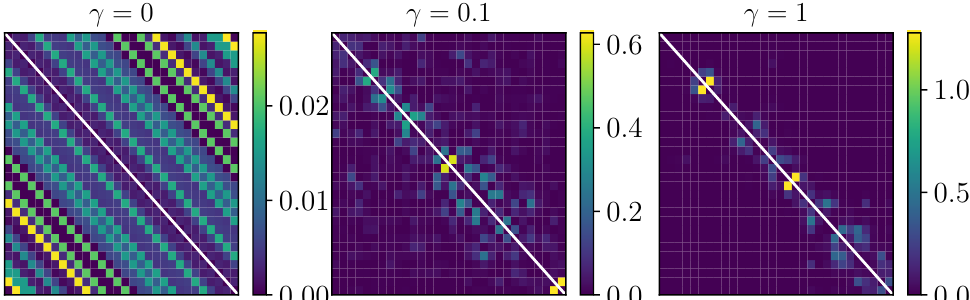
)] 30 , x (in a peri- 1 2 x 1 , x 2 = 1 = x , marked by a white 1 2